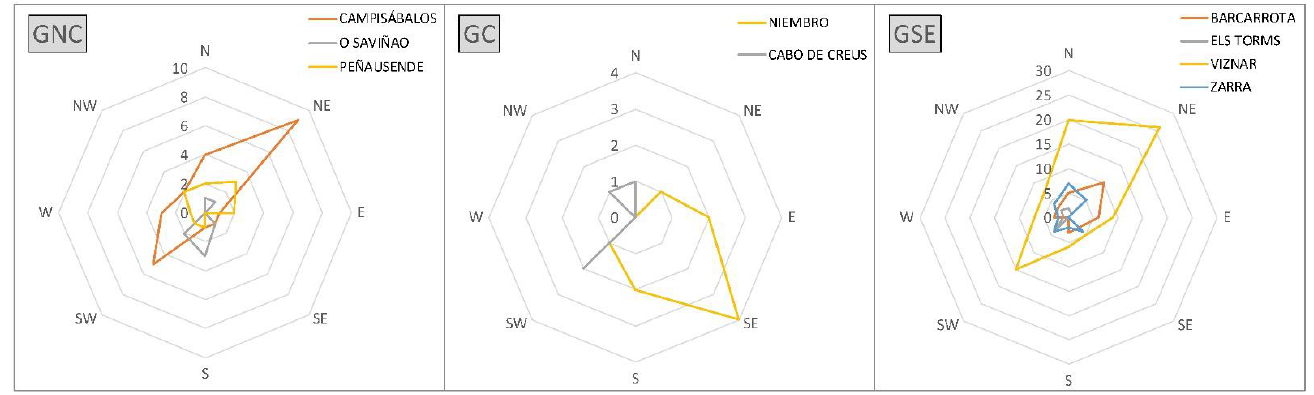
Figure 9. Wind roses showing the number of PM 10 exceedances related to Saharan intrusions for the period 2005 – 2019.